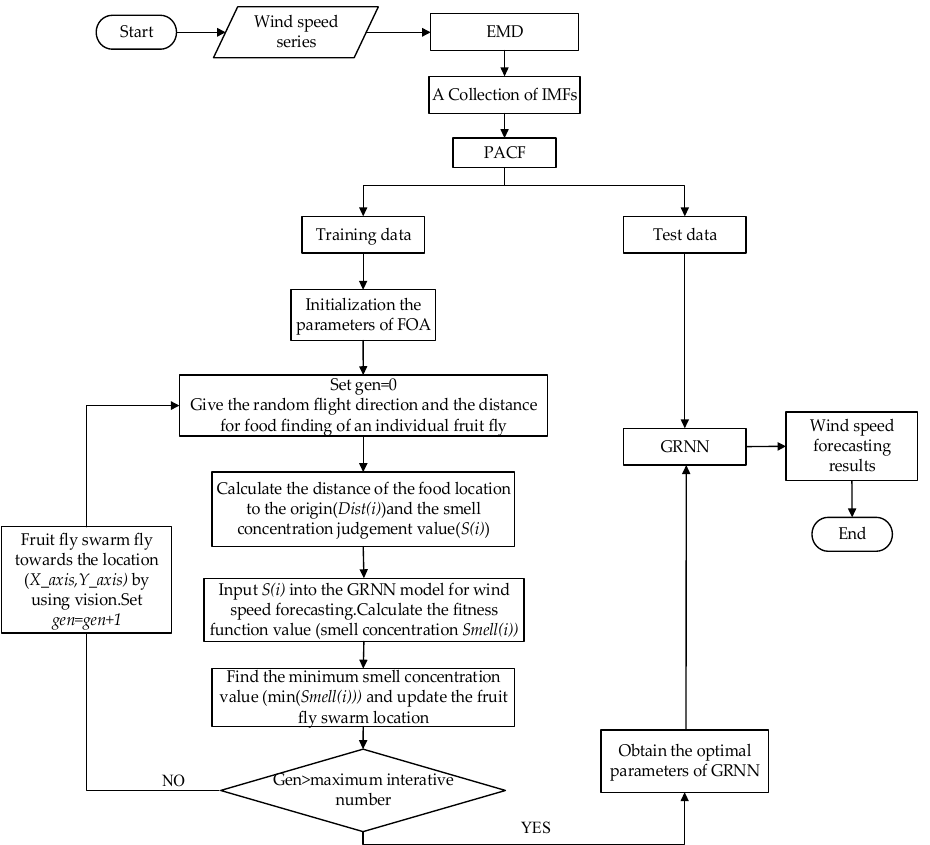
Figure 3. The flow chart of EMD-FOA-GRNN. EMD: empirical mode decomposition; IMF: intrinsic mode function; PACF: partial autocorrelation coefficient function; FOA: fruit fly optimization algorithm.